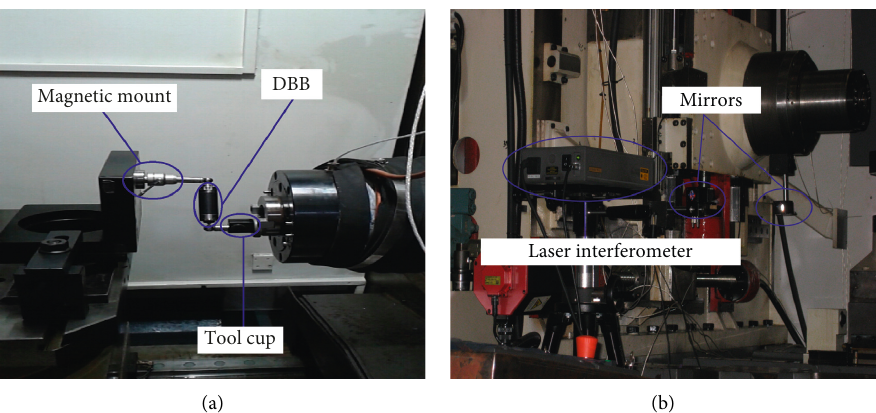
Figure 4: Measurement of 30 geometric errors for the four-axis machine tool. (a) Rotary axis measurement with a DBB. (b) Linear axis measurement with an